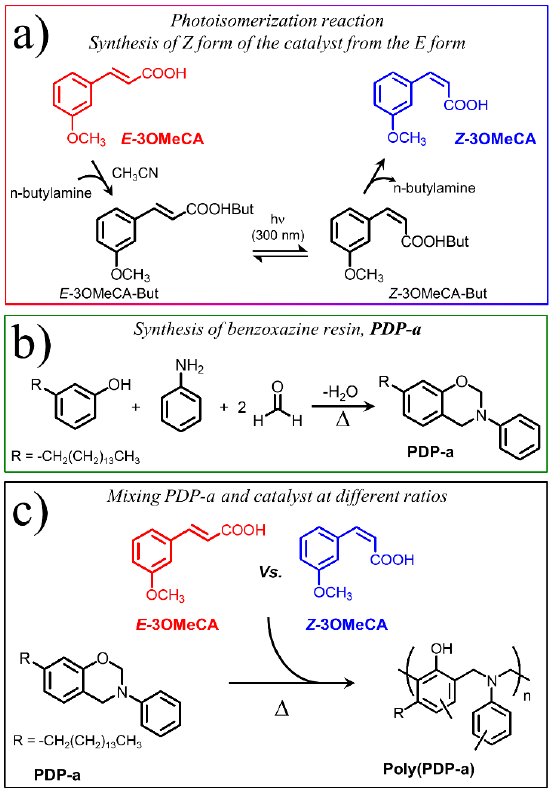
Figure 1. ( a ) General approach for synthesizing Z -forms of cinnamic derivatives. ( b ) Synthesis of